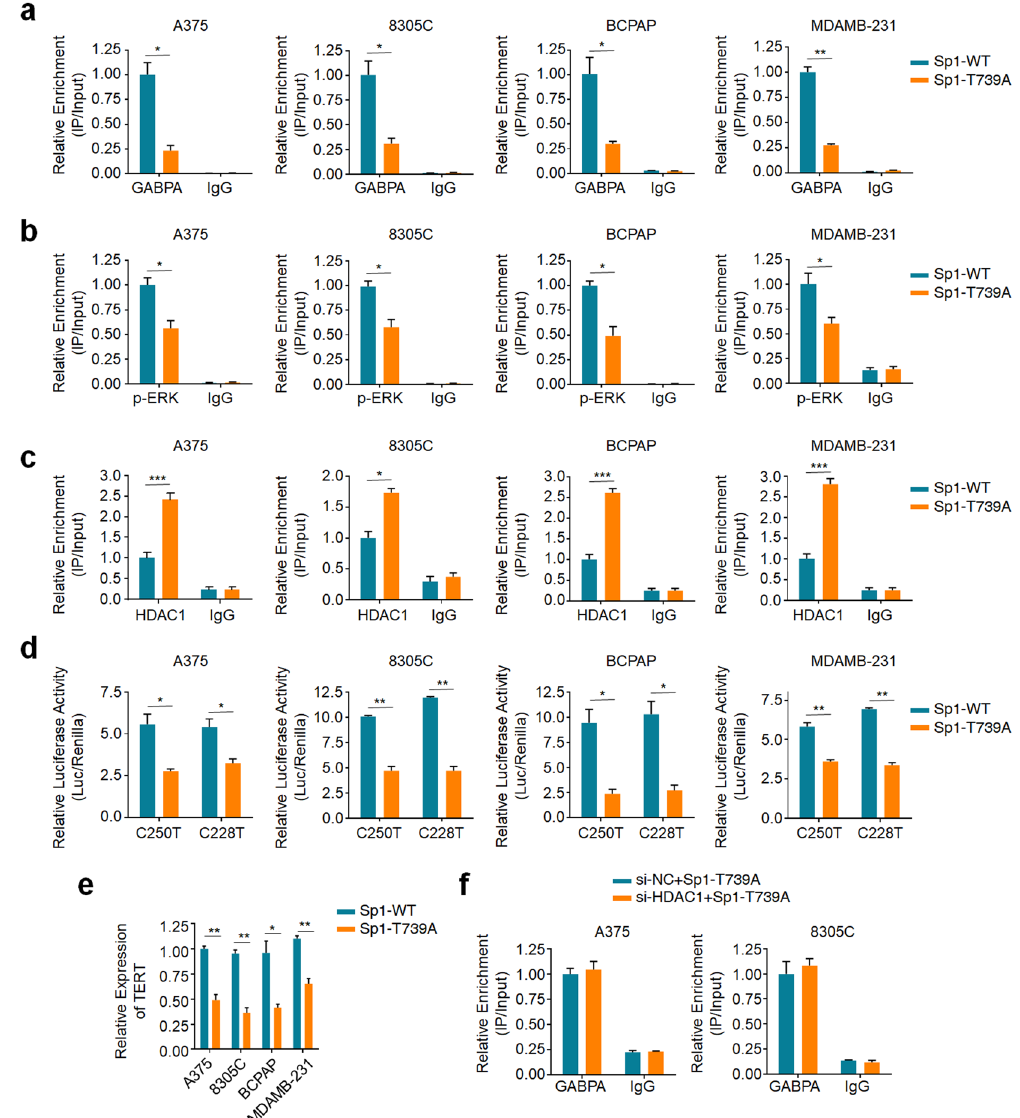
Fig. 4 Mutation of Sp1 phosphorylation site attenuates GABPA binding and the activation of mutant TERT promoter. The indicated cells were transfected with wild-type (Sp1-WT) or mutant Sp1 (Sp1-T739A) expression construct, and ChIP-qPCR assay was then performed to analyze the recruitment of GABPA ( a ), p-ERK ( b ), and HDAC1 ( c ) to mutant TERT promoter. d In vitro luciferase assay was performed to determine the effect of Sp1 phosphorylation on the activity of mutant TERT promoter in the indicated cells. e qRT-PCR assay was performed to evaluate the effect of Sp1 phosphorylation on TERT expression in the indicated cells. 18S rRNA was used as a reference gene. f ChIP-qPCR assay was performed to determine the effect of HDAC1 knockdown on the recruitment of GABPA at TERT promoter in A375 and 8305C cells expressing Sp1-T739A. Data were shown as mean ± SD. * P < 0.05; ** P < 0.01; *** P <